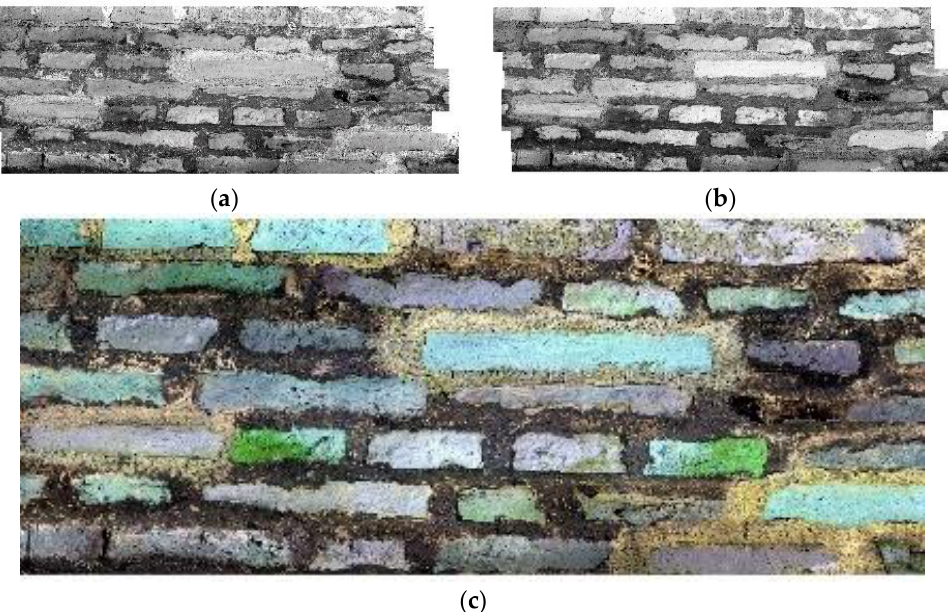
Figure 3. HSI images for ( a ) 954 nm, ( b ) 2200 nm, and ( c ) FCIR.